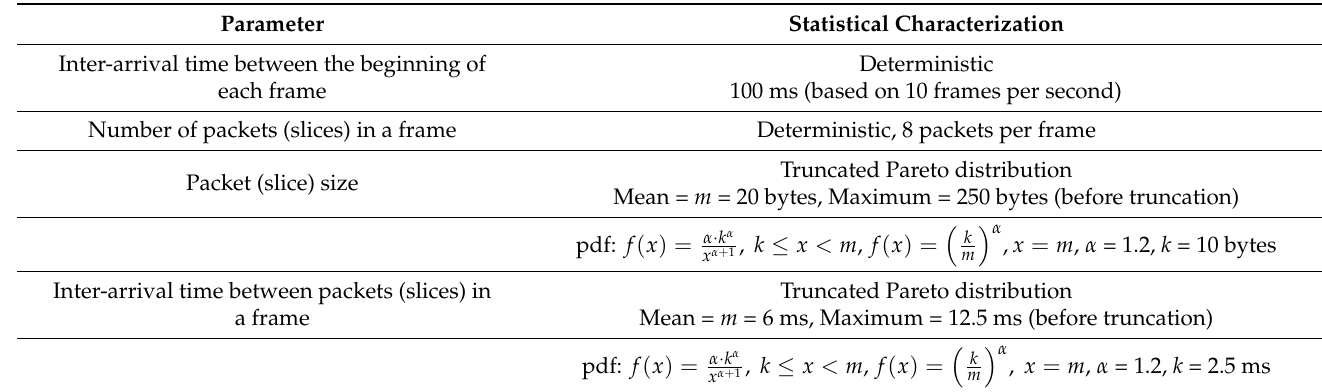
Table A4. Video streaming traffic